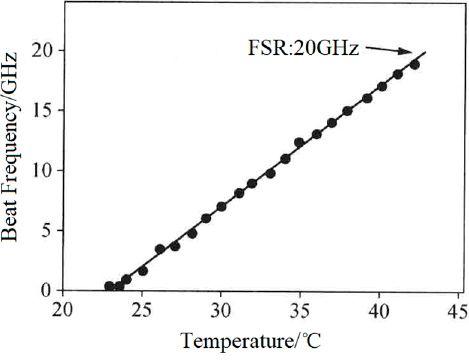
Figure 16. Dependence of frequency difference of dual-frequency laser on laser temperature [27].